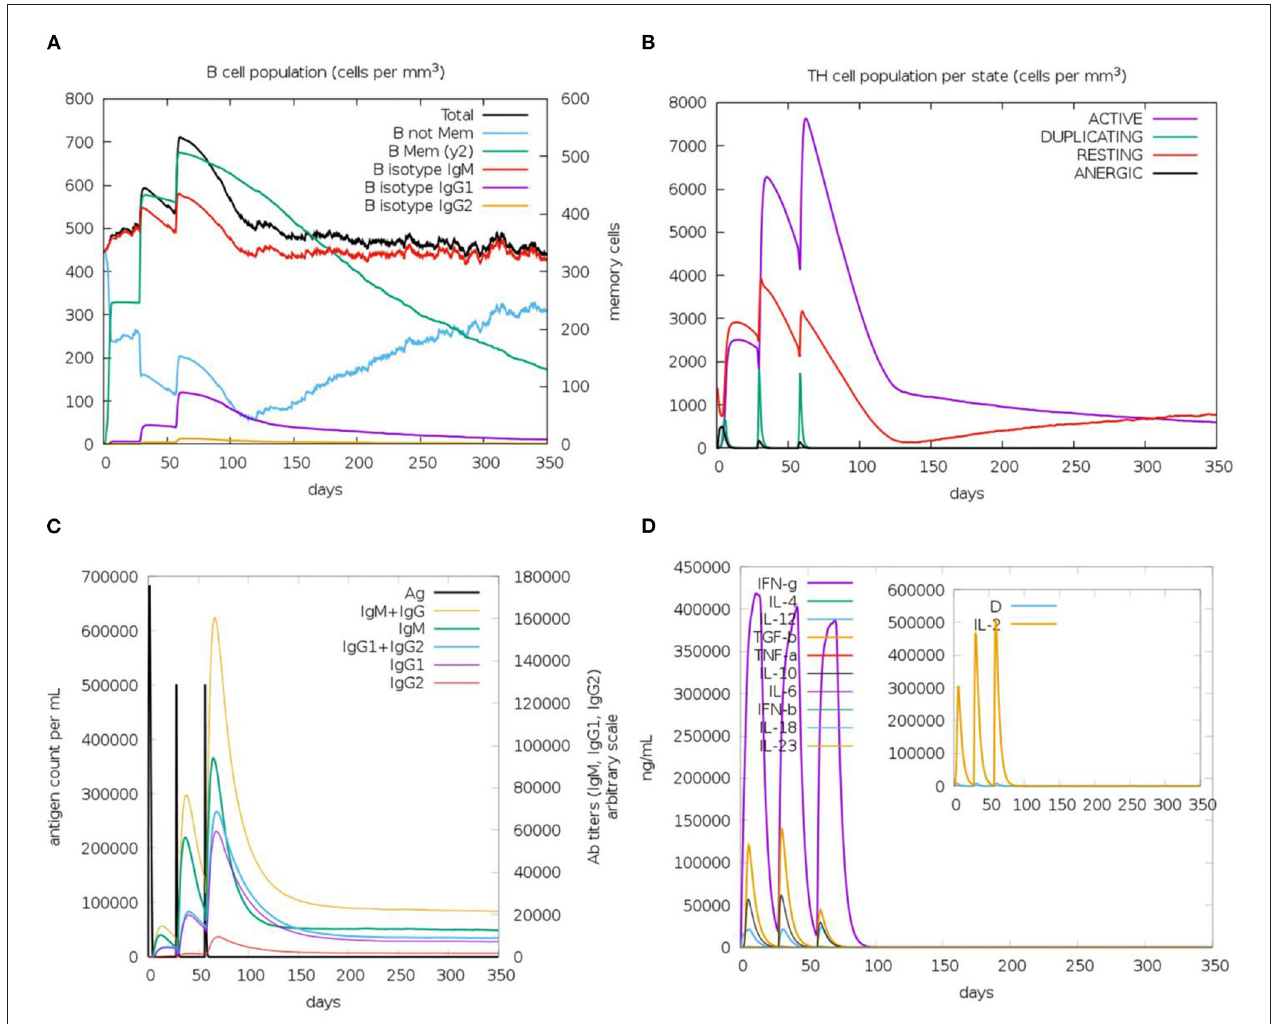
FIGURE 11 | The predicted immune response after designed vaccine injection. (A,B) shows the population of B and T cells, respectively, while (C,D) demonstrate antibody and cytokine count in a response to vaccine